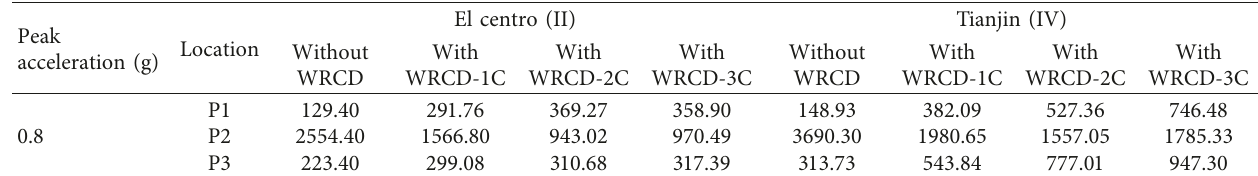
Table 4: Maximum strain for different frequency spectra ( με